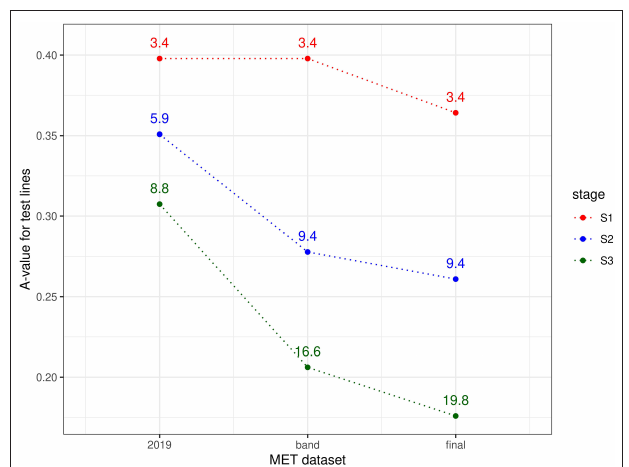
FIGURE 3 | A-values for lines under consideration for selection in chickpea breeding program in 2019 (stage S3: 58 lines, S2: 176 lines, and S1: 638 lines). A-values are given for three types of MET dataset, namely 2019 data for each stage; diagonal band of data for each stage and the final dataset constructed as in section 3.2. The points are labeled with the associated mean numbers of environments in which these lines were grown. Note that for S1 the 2019 and band datasets are the